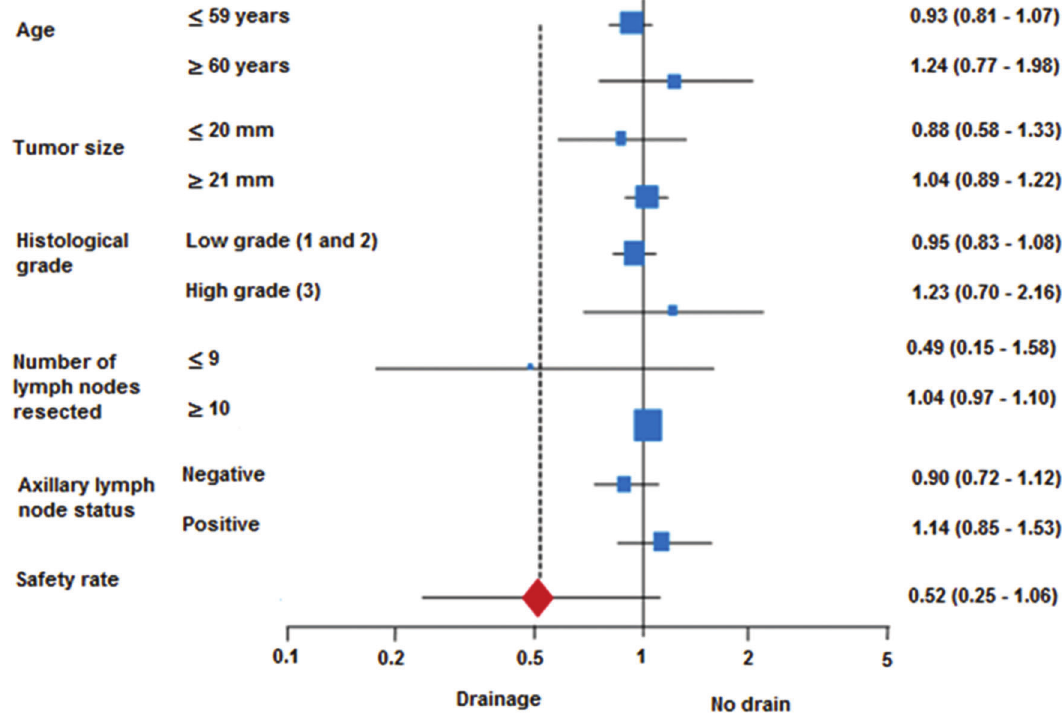
Figure 1 - Forest plot of the effect of each individual group on the safety rate. The safety rate was defined as the total number of patients without complications divided by the total number of patients in each